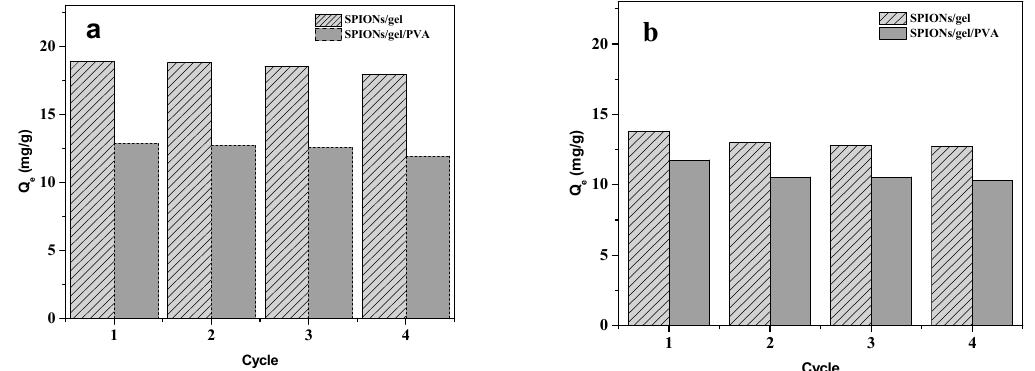
Figure 9. Regeneration of SPIONs/gel and SPIONs/gel/PVA for Cu(II) ( a ) and Zn(II) ( b ).